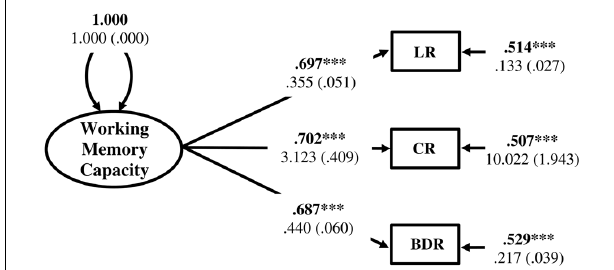
FIGURE 6 | Measurement model for the Working Memory Capacity (WMC) factor. LR, Listening Recall; CR, Counting Recall; BDR, Backward Digit Recall. Fully standardized estimates are in bold type face. Numbers below are unstandardized parameter estimates with bootstrapped standard errors in brackets. ∗∗∗ p <